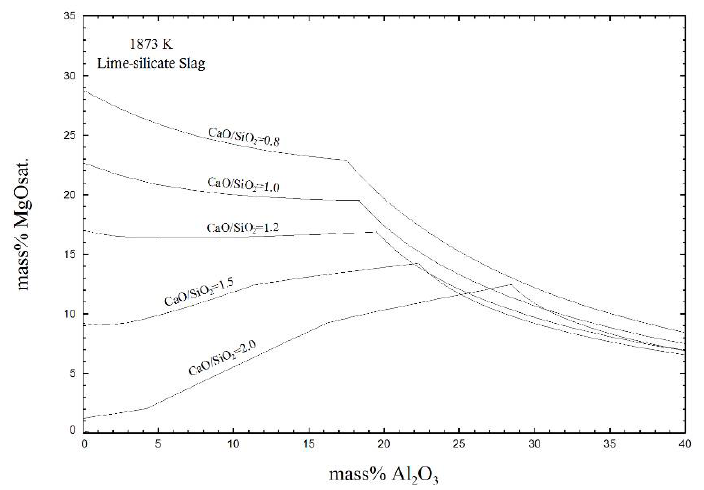
Figure 11. Effect of basicity (CaO/SiO 2 ) on MgO solubility with a low basicity of the slag at 1873 K.